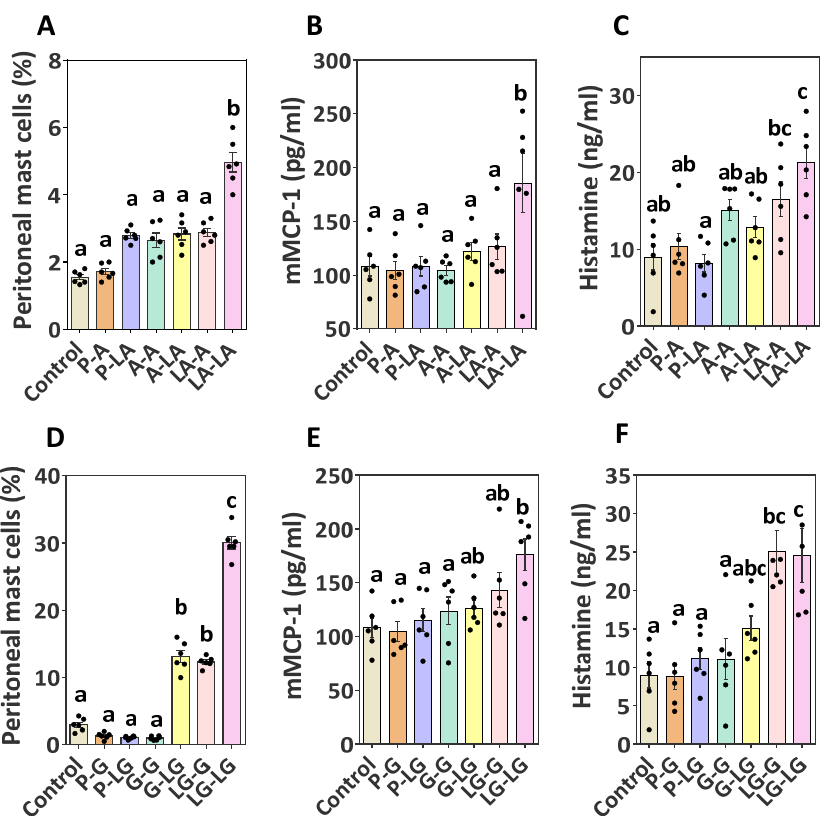
Figure 6. Identification of mast cell activation: ( A , D ) percentages of peritoneal Fc ε RI + c-kit + cells in the BLA and BLG groups, respectively; ( B , E ) levels of mMCP-1 measured in serum of the BLA and BLG groups, respectively; ( C , F ) release of histamine measured in plasma. Data were expressed as means ± SEM of six independent mice. The results are representative of two independent experiments. Statistical significance was determined by one-way ANOVA, followed by Tukey’s multiple comparisons test. The groups without the same letter in the histogram bar have statistical differences ( p < 0.05).